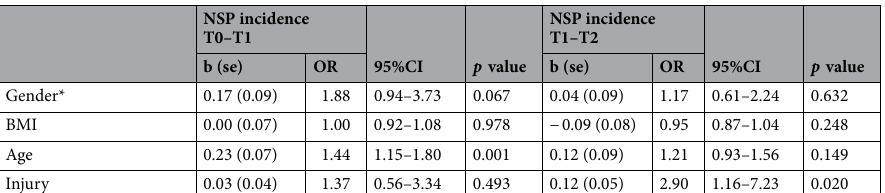
Table 3. Results of logistic regression analyses on incidence of neck and shoulder pain (NSP) in relation to independent variables in models. Variables at measurement point T0 or T1 predicting NSP incidence at next follow-up period (T0–T1 or T1–T2). *0 = boy, 1 = girl. Models are adjusted by bedtime (23.00 or later), BMI (body mass index) and spinal injuries; b = standardized regression coefficient; se = standard error. Significant values are in